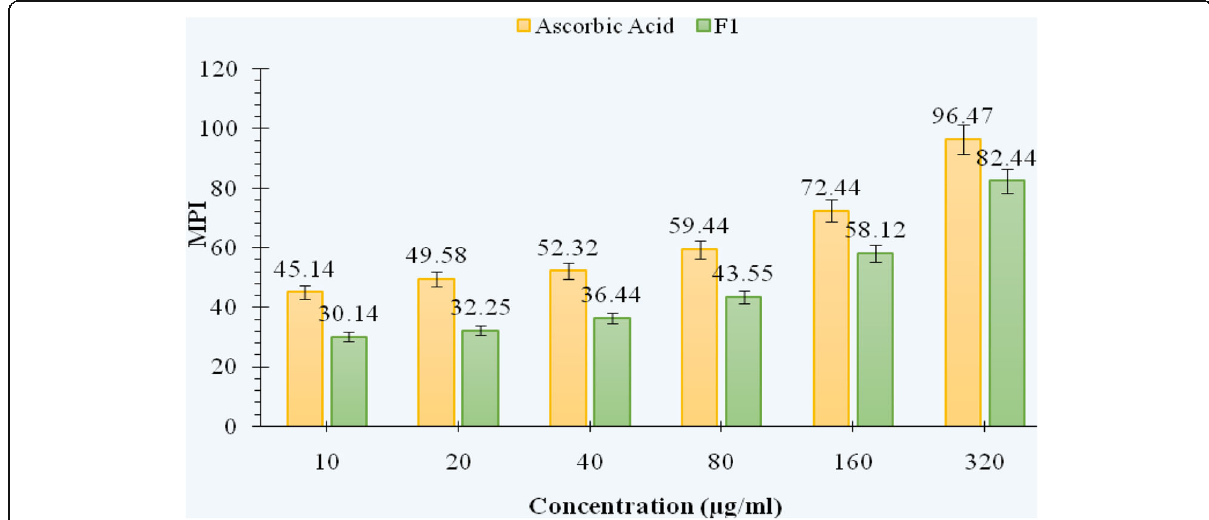
Fig. 6 Graph showing mean percentage inhibition of nitric oxide by ascorbic acid and plant extract F1